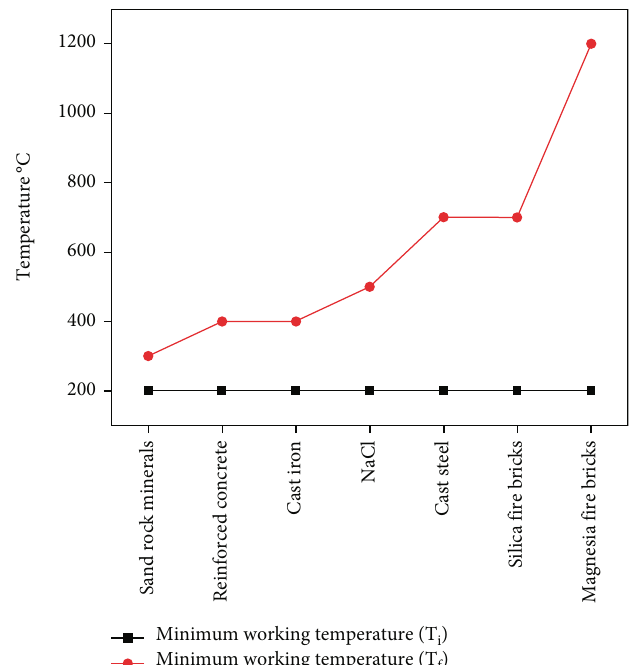
Figure 2: Temperature range of various thermal storage mediums [46, 50].